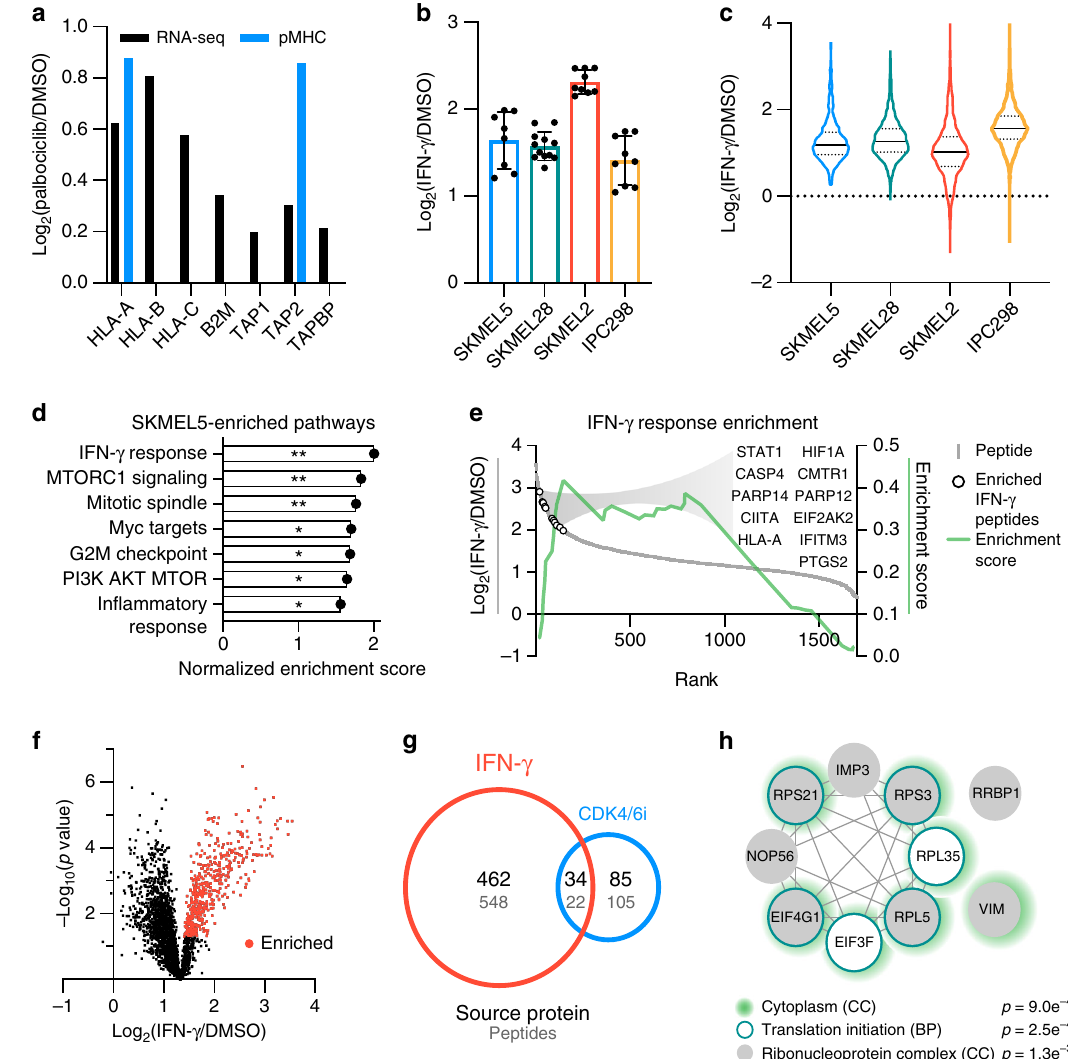
Fig. 6 Quantifying the pMHC repertoire response to IFN- γ stimulation. a RNA-seq (black) and pMHC (blue) log 2 fold change (FC) of 1 μ M palbociclib/ DMSO, calculated from the mean intensity of n = 3 biological replicates per condition, for antigen-processing genes. b Surface HLA expression via fl ow cytometry of cells treated with 72 h IFN- γ shown as log 2 (FC) (IFN- γ /DMSO). Errors bars represent ± SD, biological replicates are n = 8, 11, 9, and 9 for SKMEL5, SKMEL28, SKMEL2, and IPC298, respectively. c Immunopeptidome log 2 (FC), dotted lines display quartiles, and mean fold changes (solid line) are 2.42, 2.50, 2.08, and 3.04 for SKMEL5, SKMEL28, SKMEL2, and IPC298 cells, respectively. d Signi fi cantly enriched pathways in SKMEL5 cells with 72 h IFN- γ , q < 0.25, * p < 0.05, ** p < 0.01. e Enrichment plot of IFN- γ response enrichment in SKMEL5 cells displays running enrichment score (green, right y -axis), and the log y -axis) versus rank ( x -axis) for each peptide (gray). Open circles show signi fi cantly enriched IFN- γ peptides. f Volcano plot of 2 (FC) (left IFN- γ -induced changes in SKMEL5 cells. Peptides are presented as the log 2 (FC) versus mean-adjusted p value (unpaired two-sided t test). Red points represent peptides signi fi cantly enriched ( p < 0.05, fold change > 2.42). g Venn diagram of signi fi cantly enriched source proteins (black) or peptides (gray) between IFN- γ and 1 μ M palbociclib-treated SKMEL5 cells. h Protein – protein interaction network of signi fi cantly enriched source proteins in common, annotated by enriched gene ontology cellular components (CCs) and/or biological professes (BPs). Signi fi cance values are false discovery rate (FDR) adjusted. Exact signi fi cance values and other Source data are reported in the Source Data